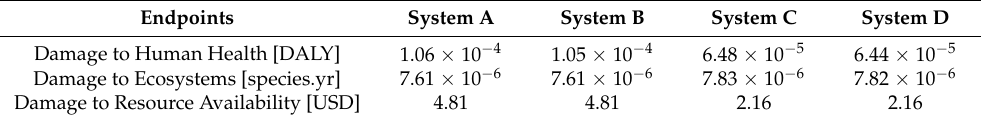
Table 1. Endpoint categories.